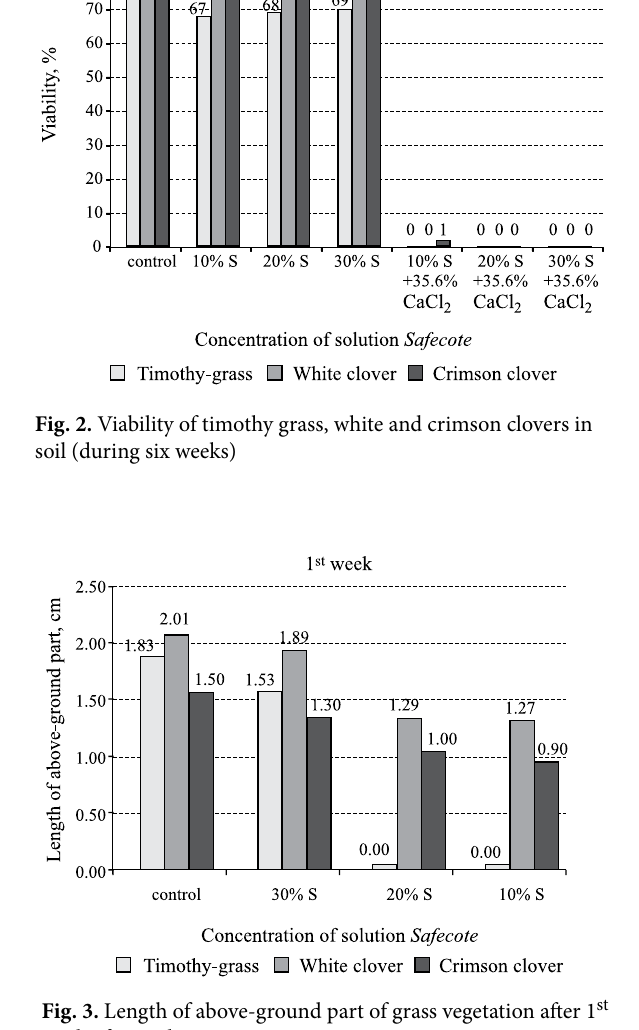
Fig. 3. Length of above-ground part of grass vegetation after 1 st week of growth